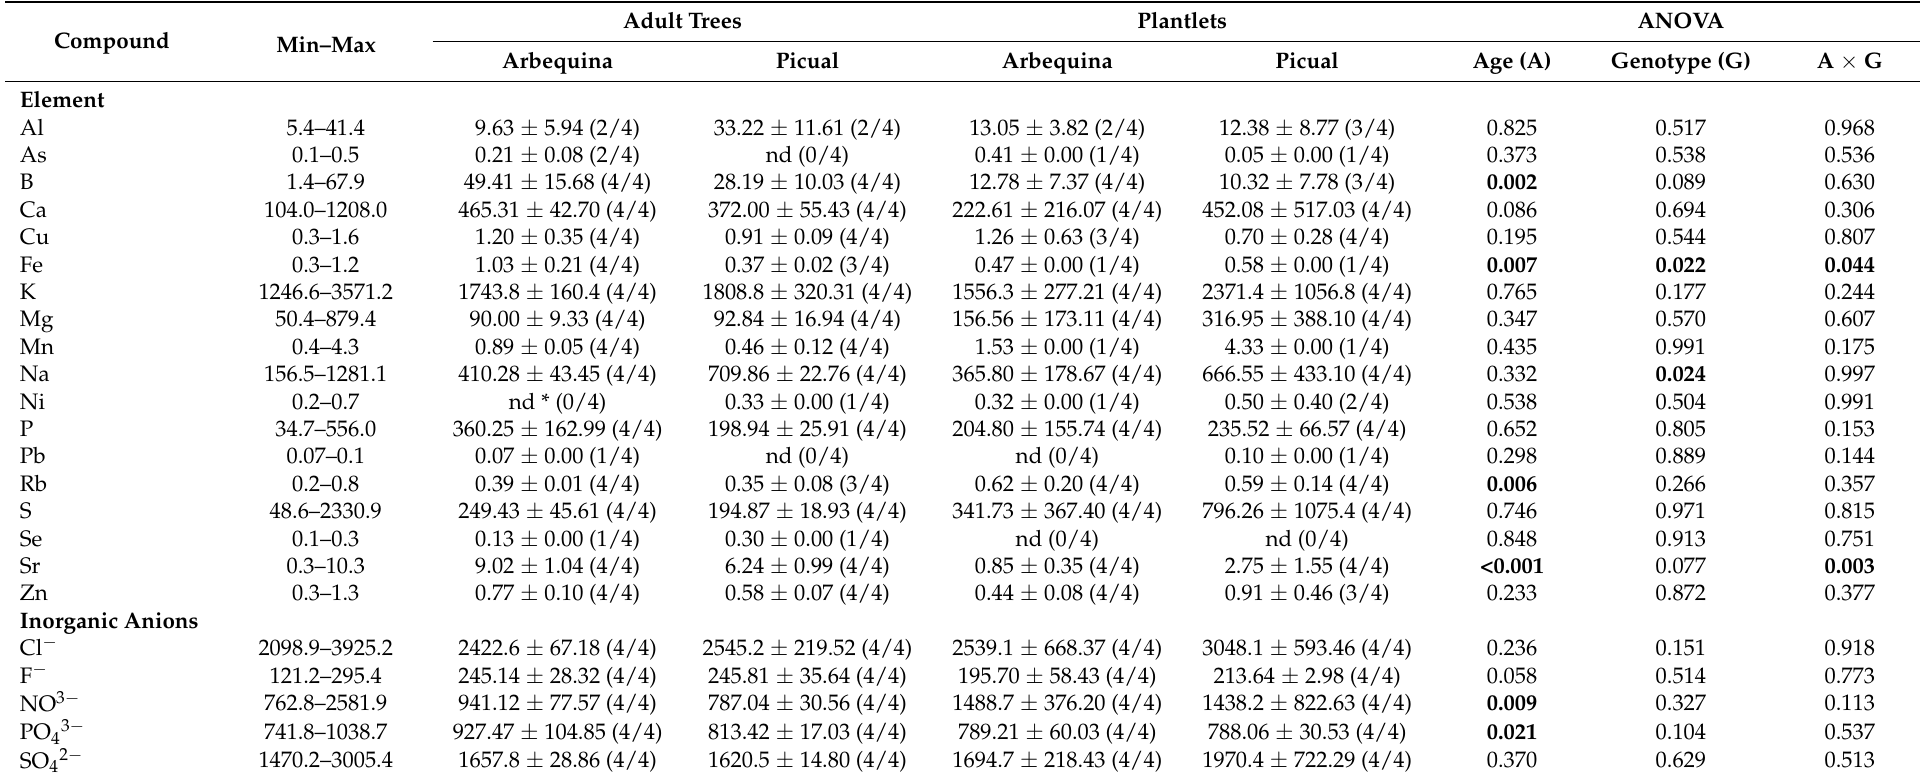
Table 2. Mean content ( µ M) and range of the main groups of elements and inorganic ions present in xylem sap from plantlets and adult olive trees of ‘Picual’ and ‘Arbequina’ genotypes and results of ANOVA analysis ( p -values of F test) to determine the effects of plant age and genotype. For each treatment mean values and standard derivation are shown. Detection of each compound in the total samples tested is displayed in